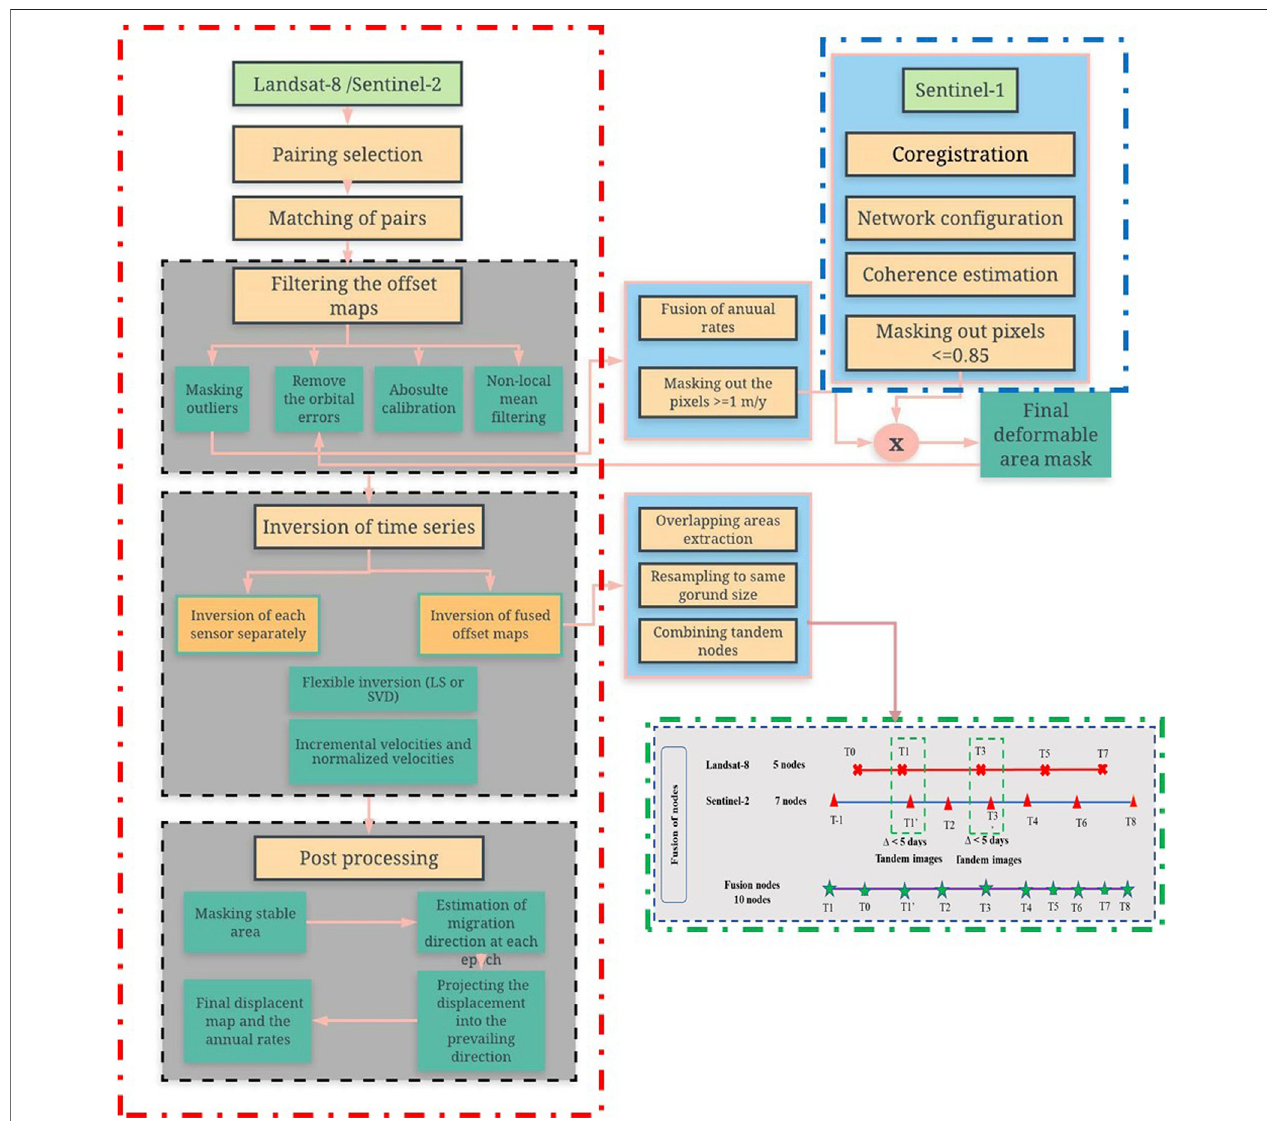
FIGURE 3 | Flowchart of the processing chain. The steps outlined by the blue dashed rectangle represent the processing steps to estimate the multitemporal spatial coherence. The steps outlined by the red dashed rectangle denote the optical image matching selection and inversion algorithm. The green dashed rectangle denotes the concept of combining tandem images when merging data from the two